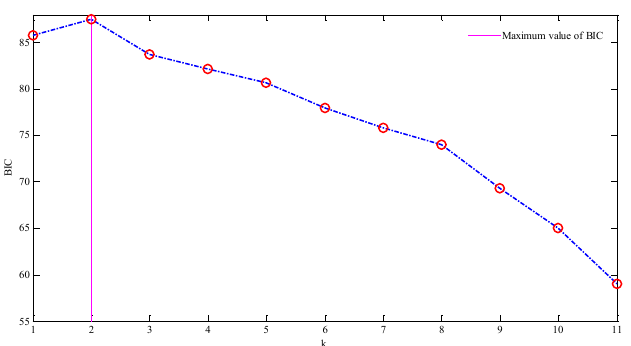
Figure 5. The Bayesian information criterion (BIC) value of composite original.